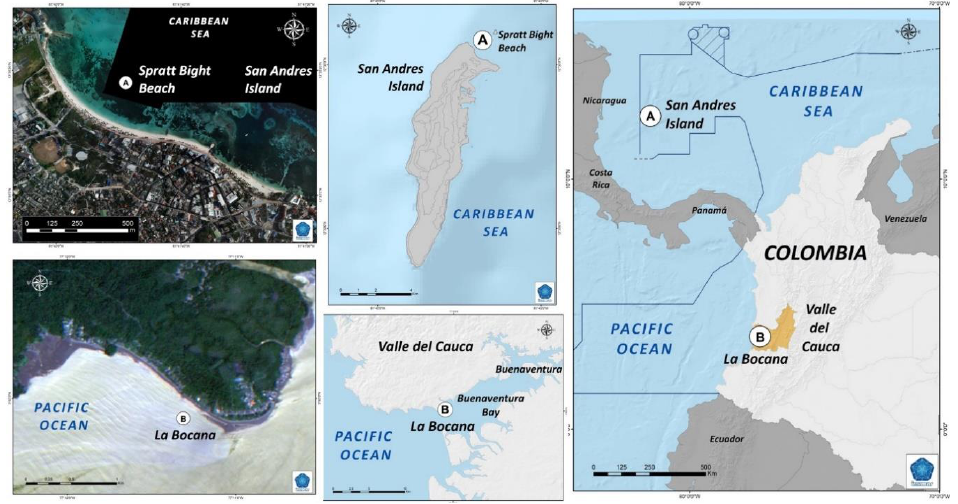
Figure 1. Study area. ( A ) Spratt Bight, San Andrés Island, Caribbean coast. ( B ) La Bocana, Buenaventura bay, Pacific coast.